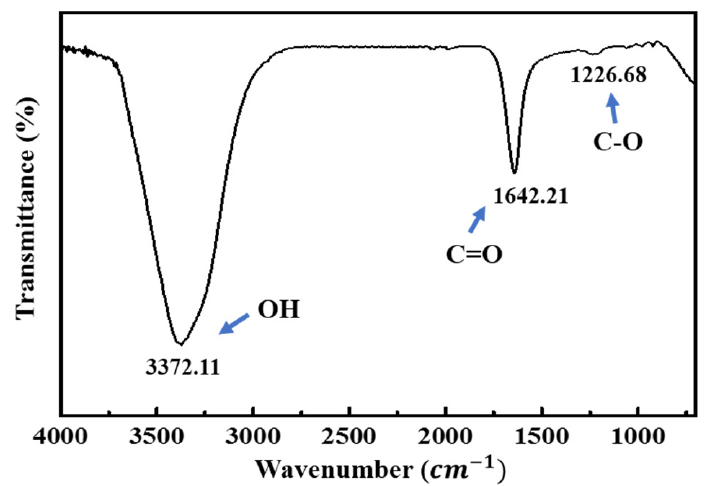
Figure 1. FTIR spectra of MWCNT modified with COOH.